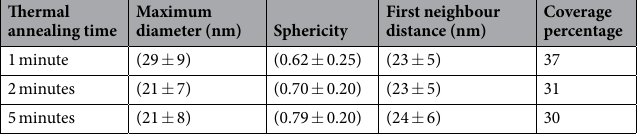
Table 1. Statistical data related to the dimension of the nanoparticles and